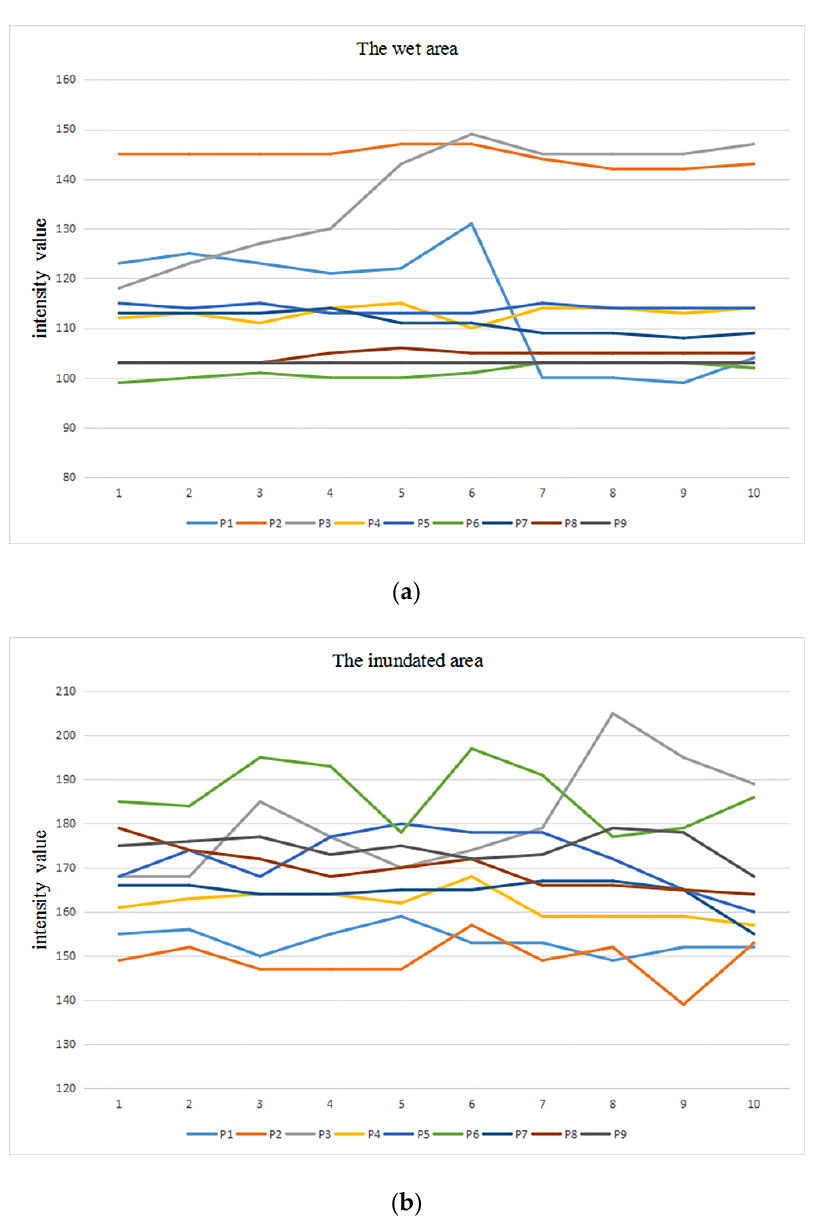
Figure 12. Line charts of sample points’ intensity value: wet areas ( a ) and inundated areas ( b ).